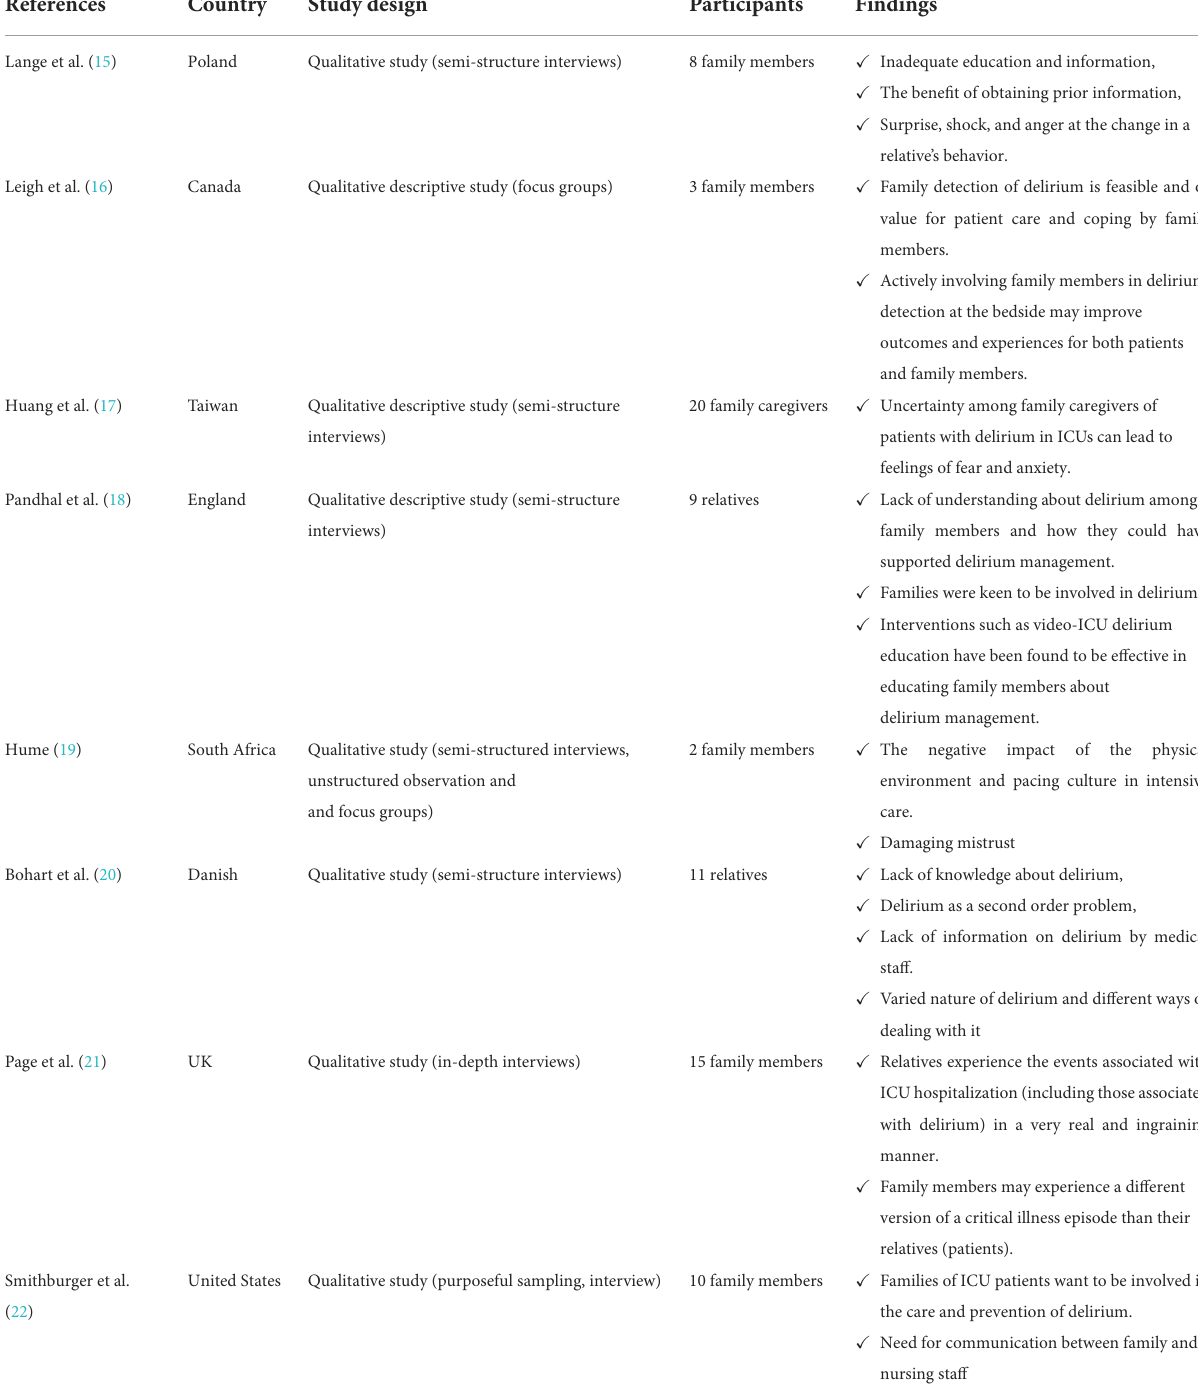
TABLE 1 Characteristics and findings of qualitative study included in scoping